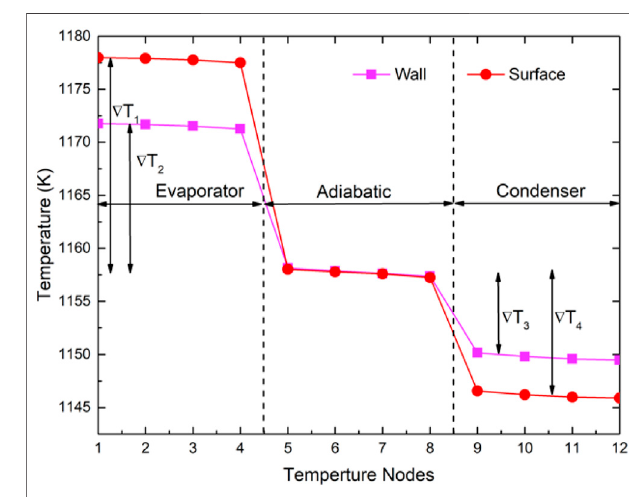
FIGURE 14 | Temperature distribution along the heat transport